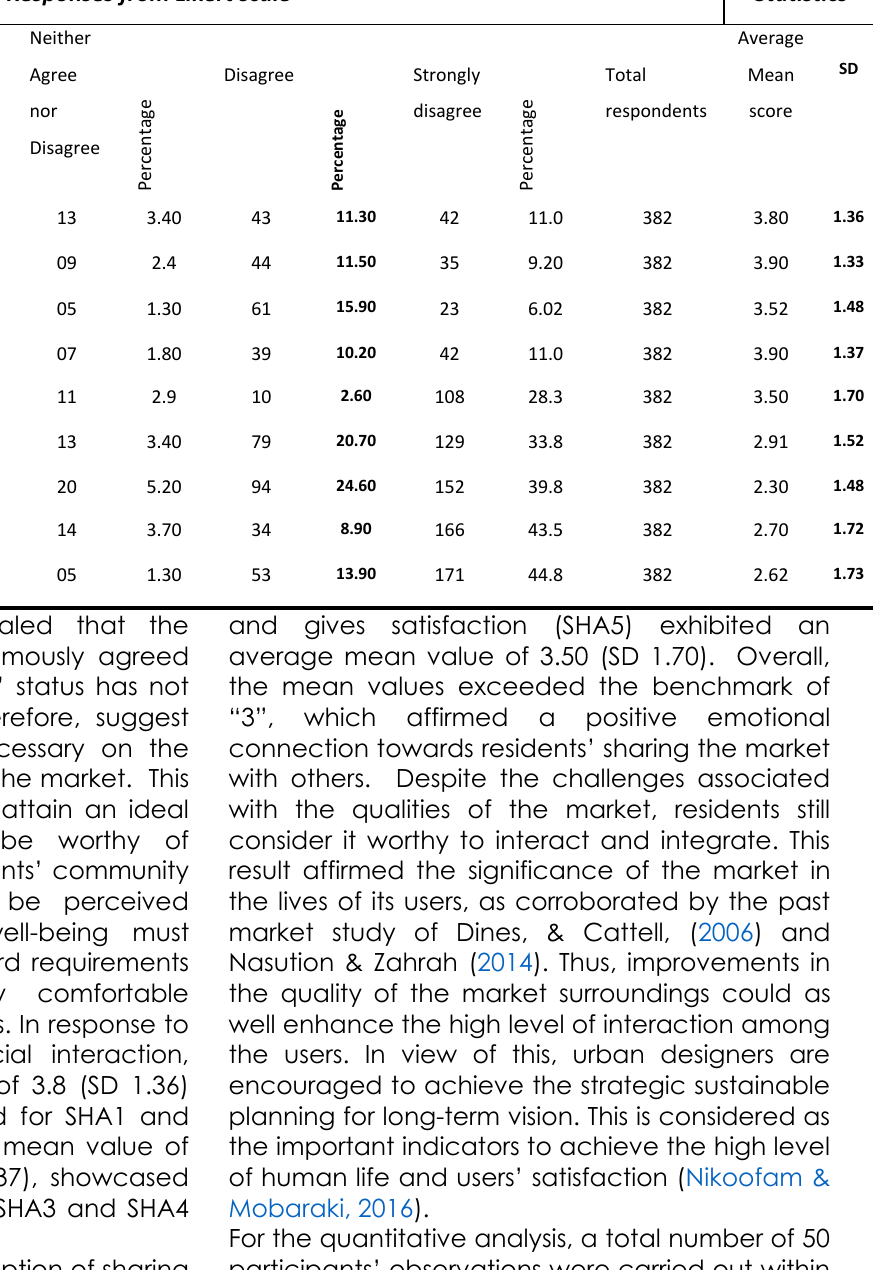
Table 1. Quantitative Result from the descriptive analysis Responses from Likert